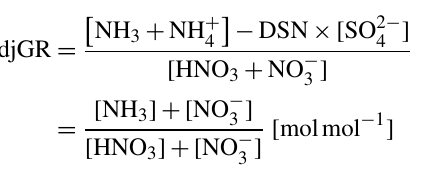
Figure 11. The path analysis of the model results along trajectory T N . (a) Temperature and relative humidity; (b) SO 2 − the bottom) and SO 2 ; (c) HO 2 concentration, (d) NO − , HNO 3 , NO, NO 2 , other NOy (NO 3 , HNO 2 , N 2 O 5 , and PANs), and coarse-mode 3 NO − ; (e) NH + and NH 3 ; (f) adjGR, F s , and F (cid:48) n . In (b) , (d) , and (e) , BC and CO concentrations normalized to the maximum value are 3 4 also shown. The time axis indicates the backward time from Fukuoka. The brown and blue bars at the bottom are schematic images of the trajectory location over land and